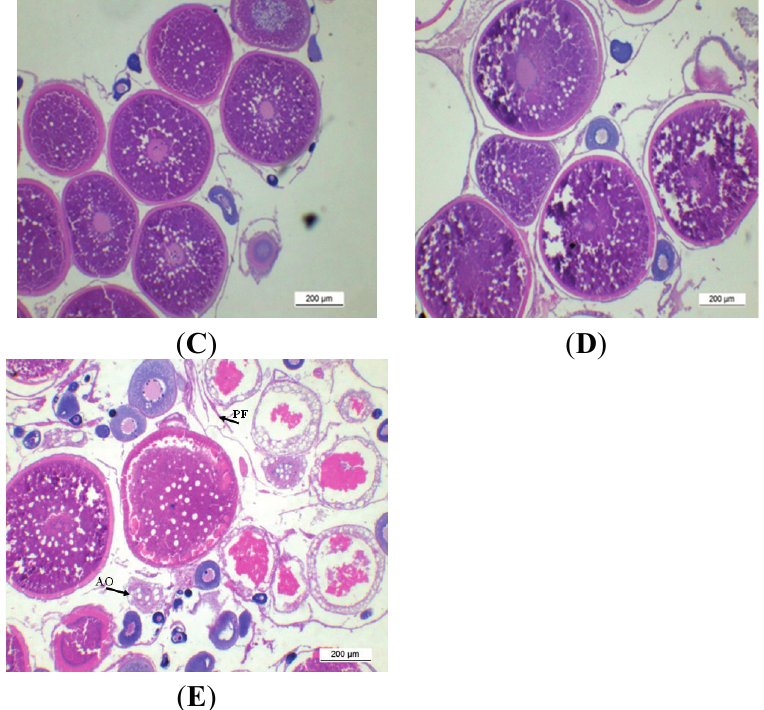
Figure 1. Representative stained sections for each of the five stages of C. semilaevis ovarian development. ( A ) previtellogenesis, ovary in stage II, bar = 100 μ m; ( B ) vitellogenesis, ovary in stage III, bar = 100 μ m; Balck arrow denotes vitellogenic oocyte; ( C ) late vitellogenesis, ovary in stage IV, bar = 200 μ m; and ( D ) maturation, ovary in stage V, bar = 200 μ m; ( E ) After ovulation, ovary in stage VI, bar = 200 μ m; Balck arrows indicate post-ovulatory follicles or atretic oocyte. VO: Vitellogenic oocyte; PF: Post-ovulatory follicles; and AO: Atretic oocyte.